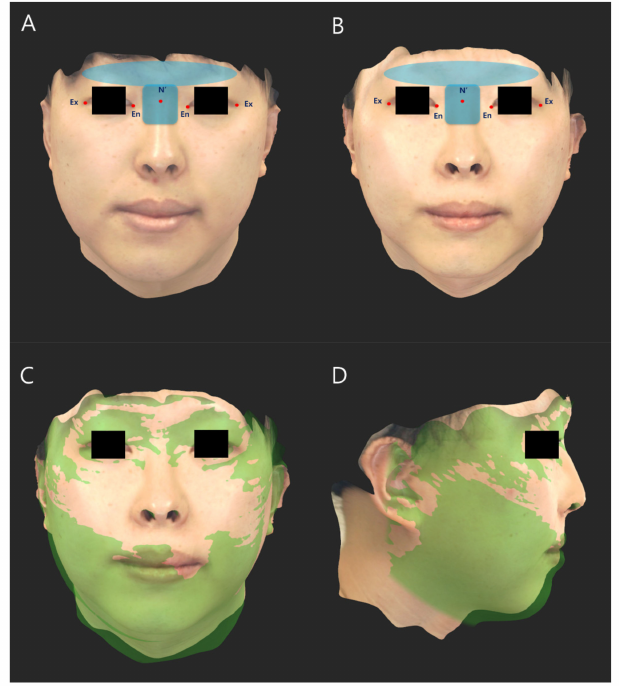
Figure 2. Superimposition of preoperative (T1) and postoperative (T2) images of the facial scanner. The references used for superimposition were the forehead and nasal bridge area (blue color), exocanthions, endocanthions, and nasal alas. ( A ) Preoperative FS image, ( B ) postoperative FS image, and ( C , D ) superimposed images. N’, soft tissue nasion; Ex, exocanthion; En, endocanthion; and Al, nasal ala.